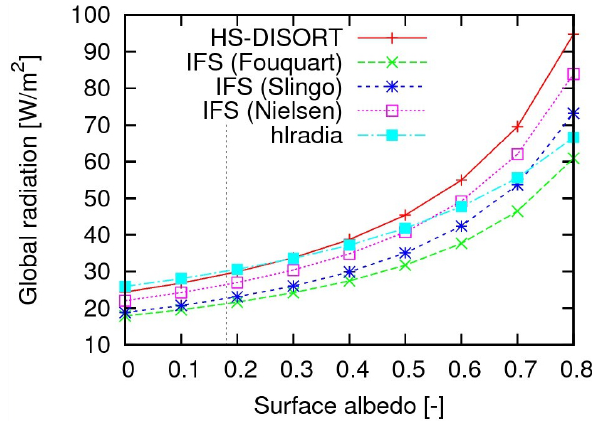
Figure 21. As for Fig. 20 but for surface albedo for the case of a thick cloud (experiment 7).